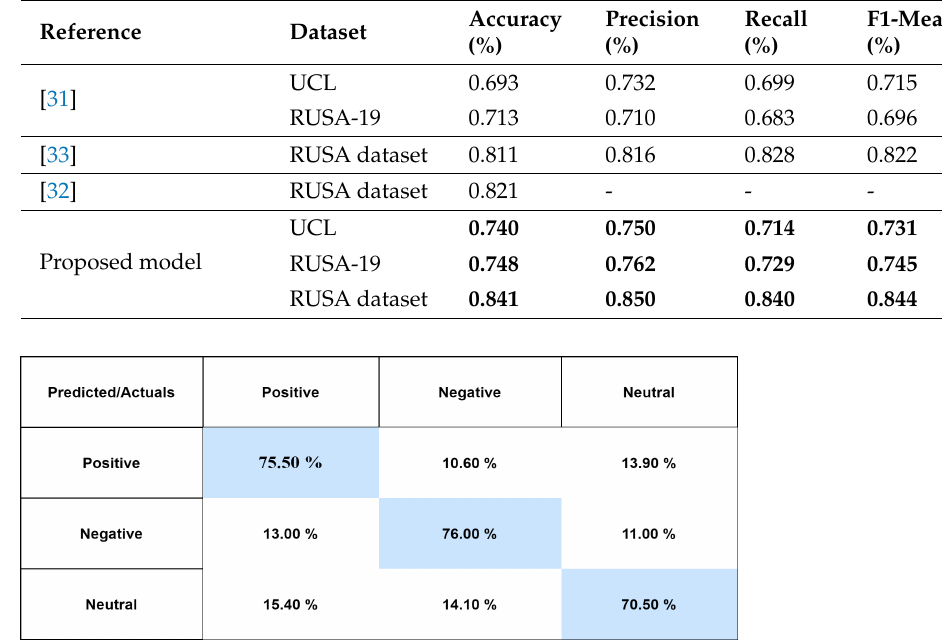
Table 9. Proposed CNN-LSTM Roman Urdu model comparison with existing models.